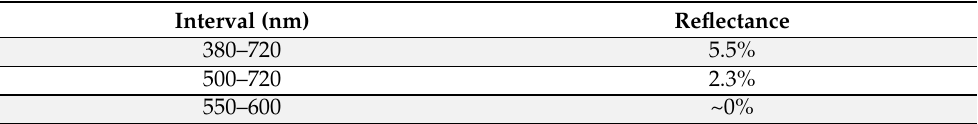
Table 4. Average reflectance values of using ZnO nanoparticles with radius 38 nm as an ARC